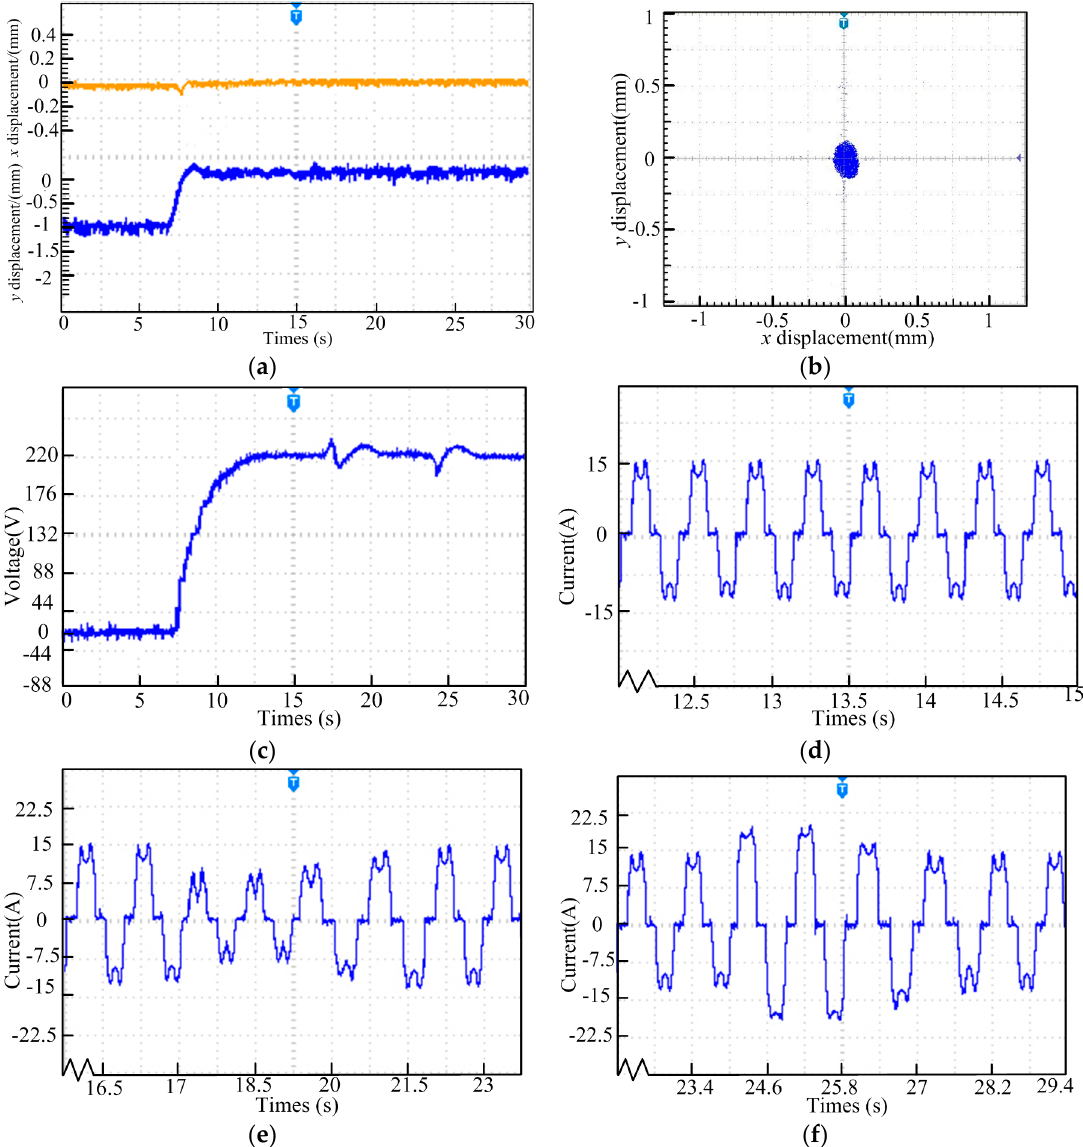
Figure 14. The experimental results based on compensation control strategy of flux ‐ linkage observation. ( a ) Radial displacement waveforms of x ‐ and y ‐ direction when the start of suspension; ( b ) The relationships between radical displacement of x ‐ and y ‐ direction for HEBPMG; ( c ) Generating voltage of HEBPMG in the process of operation; ( d ) The winding current waveform under rated load; ( e ) The winding current waveform under load shedding conditions; ( f ) The winding current waveform under overload conditions.